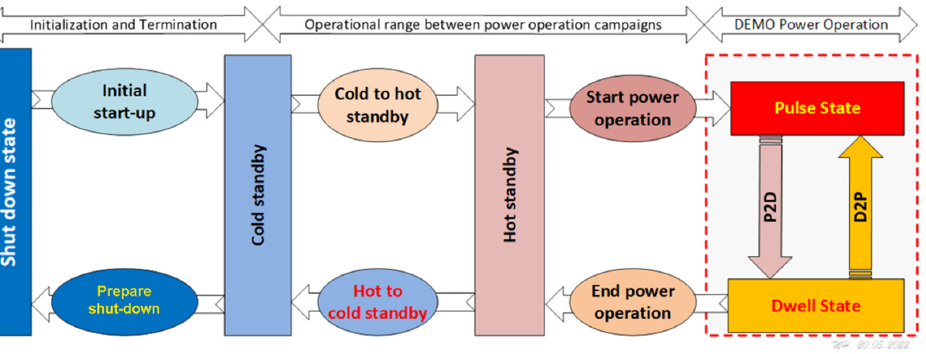
Figure 2. DEMO BOP operation modes, including states and